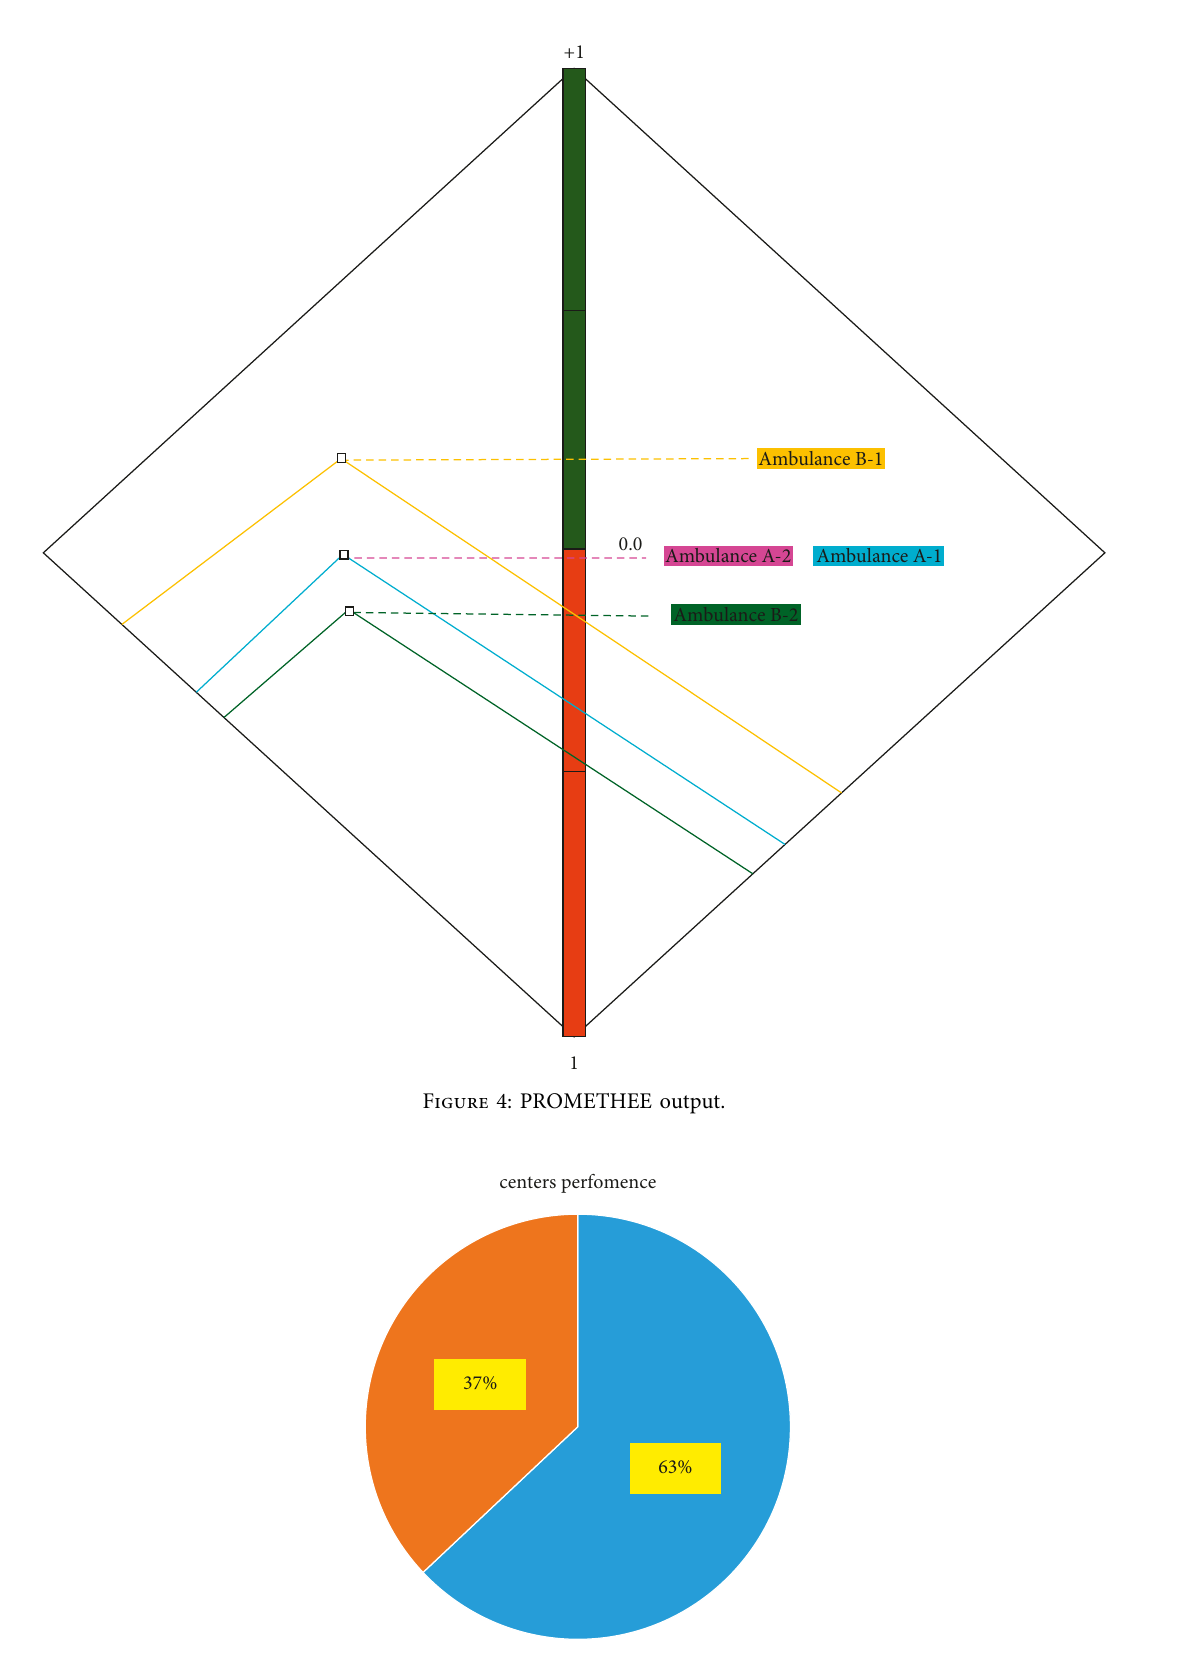
Figure 5: Performance of each